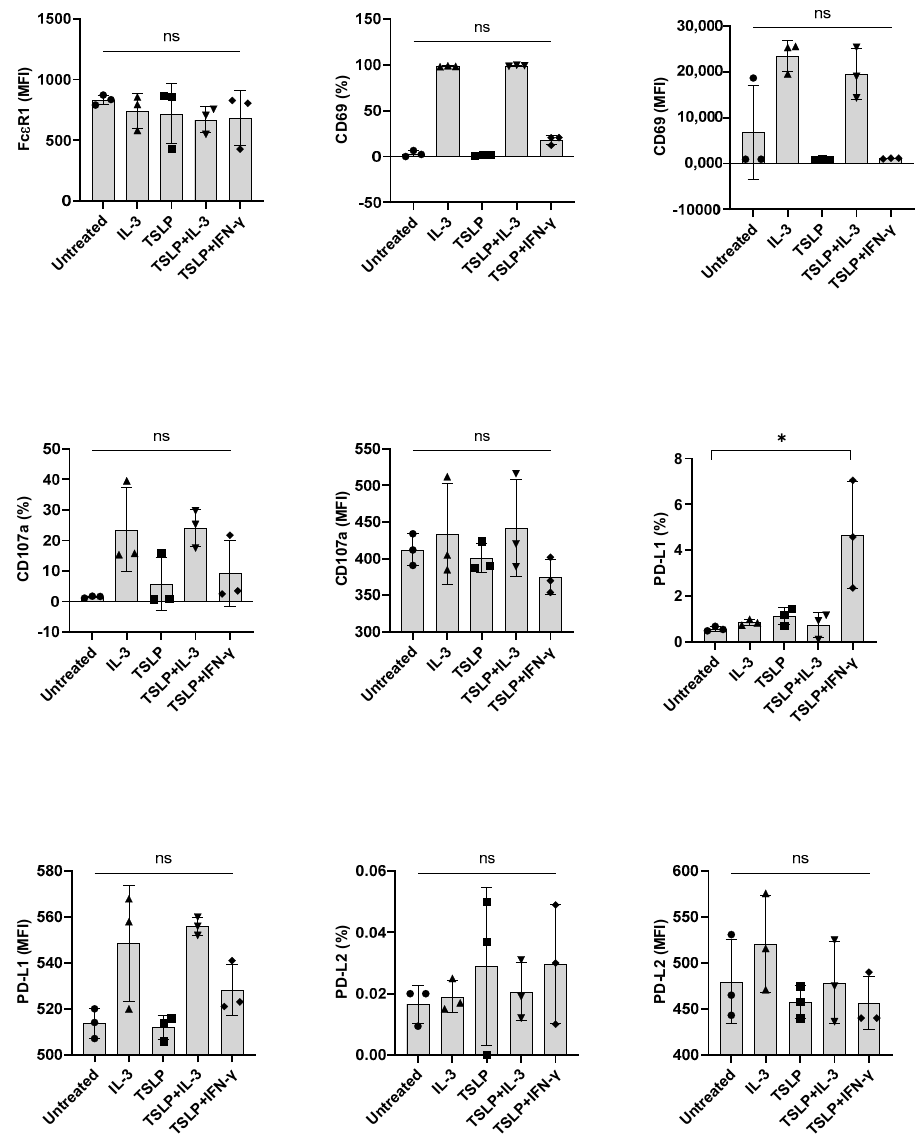
Figure 5. The effect of TSLP on the expression of PD-L1 induced by IFN- γ in primary human basophils. Basophils (0.1 × 10 6 cells/200 µ L/96-well plate) isolated from PBMCs of healthy donors were cultured with either IL-3, TSLP (10 ng/mL), TSLP + IL-3 or TSLP + IFN- γ . Basophil phenotype was evaluated by flow cytometry after 24 h. Expression of Fc ε RI, CD69, CD107a, PD-L1, and PD-L2 on the basophils (% positive cells and median fluorescence intensities (MFI), mean ± SD; n = 3 independent donors from three independent experiments) was presented. ns, not significant, * p < 0.05, one-way ANOVA Friedman test with Dunn’s multiple comparisons